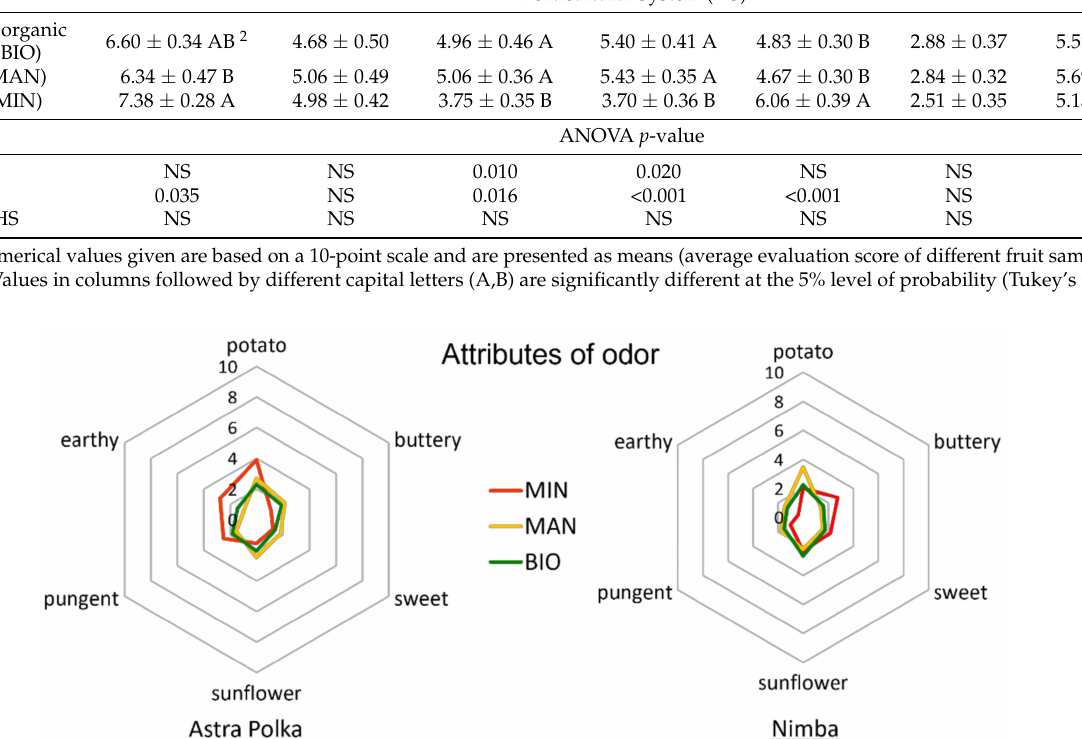
Figure 2. Intensity of odor attributes of courgette fruits of Astra Polka and Nimba cultivars grown in horticultural system with